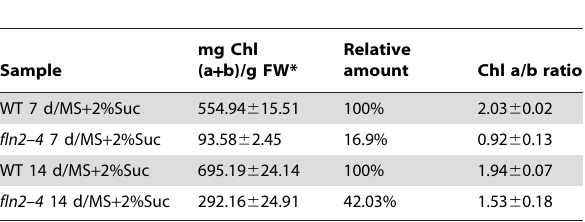
Table 1. Chlorophyll accumulation in the WT and fln2–4 mutants.